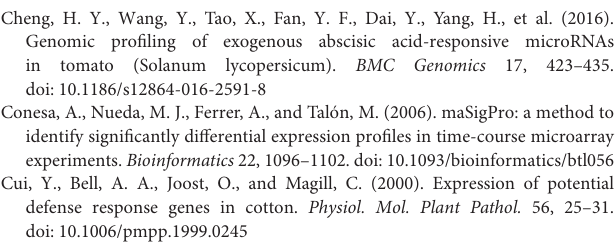
Supplementary Table S5 | Details of differentially expressed profiles (clusters) including genes involved in the lignin synthetic pathway. Supplementary Table S6 | Primers used for